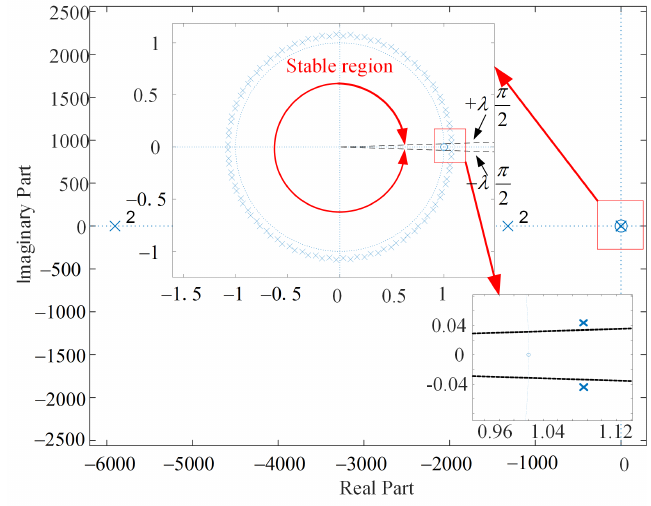
Figure 18. Pole plot of the designed FOIC closed-loop control system considering the robot manipu- lator system.